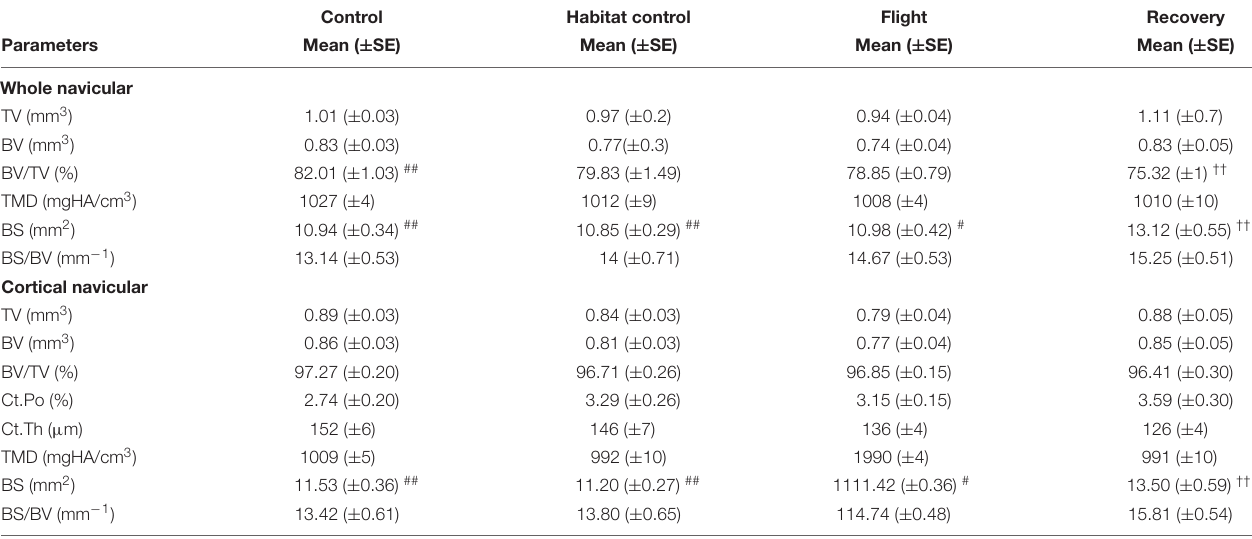
TABLE 4 | Effect of spaceflight, spacecraft housing, and recovery on navicular microarchitecture parameters.